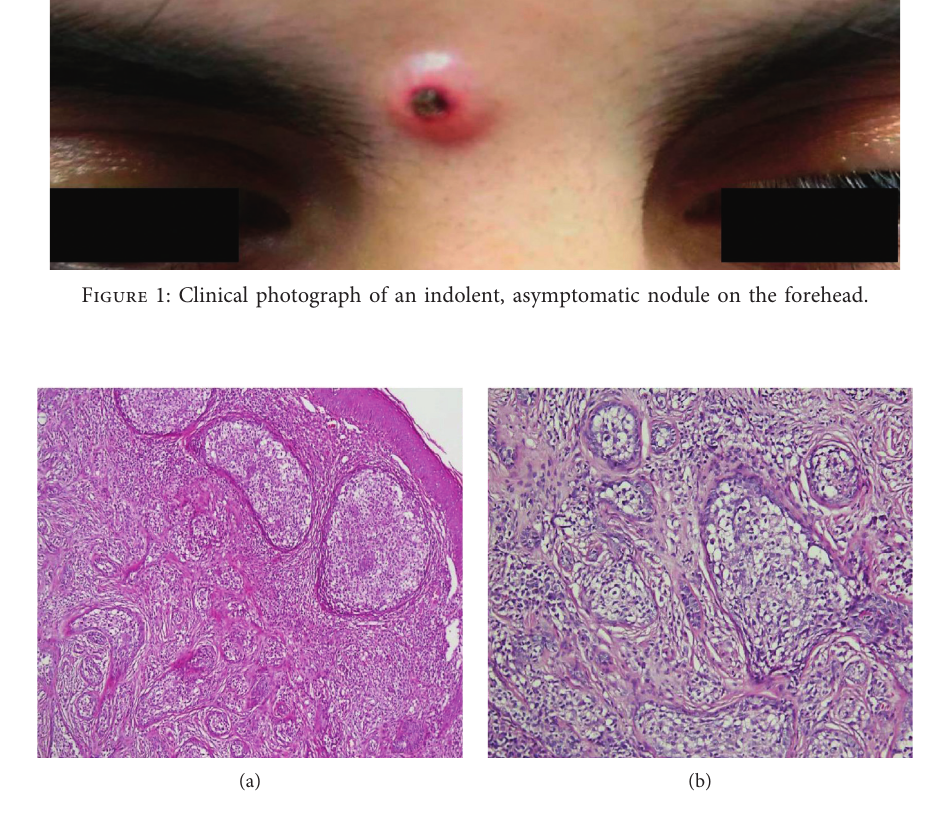
Figure 2: (a) Histopathological findings demonstrate ill-defined interconnected islands of epithelial cells within a sclerotic stroma (4x). (b) The epithelial cells have eosinophilic to clear cytoplasm and mild pleomorphic vesicular nuclei (10x). A peripheral rim of palisading basophilic cells surrounds the epithelial islands. A prominent lymphocytic infiltration and few plasma cells that spill over to the epithelial nests is also present